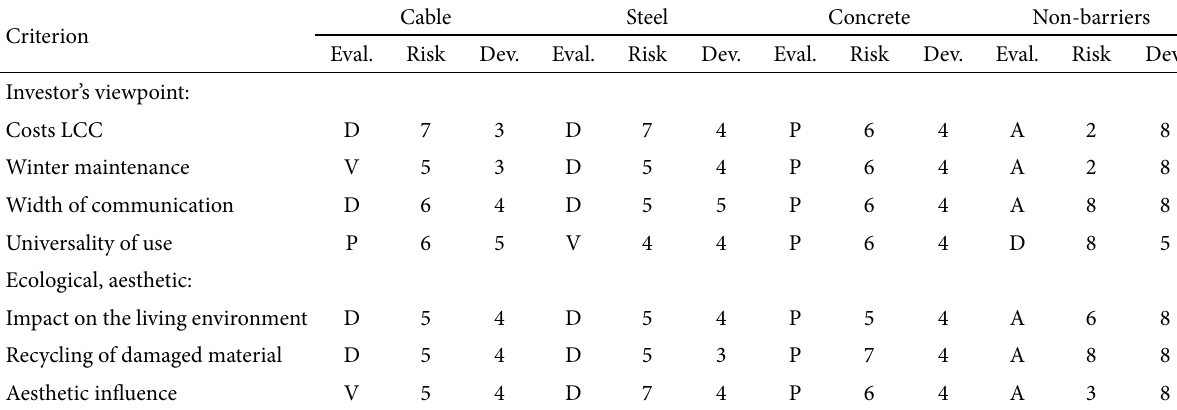
Table 4. Expert evaluation of variants (part I) Criterion